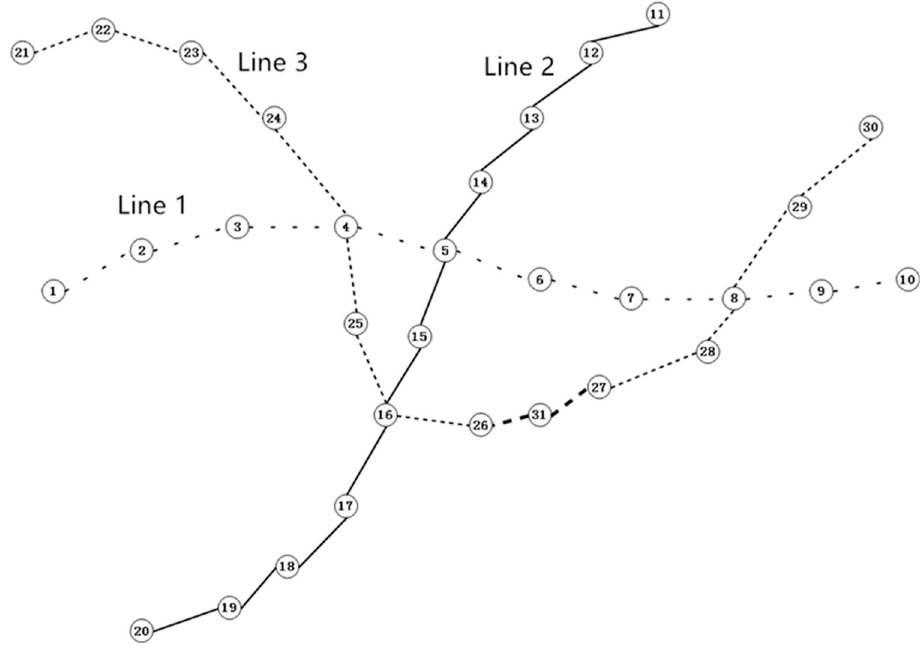
Figure 11. Bus network diagram after adding the new station.